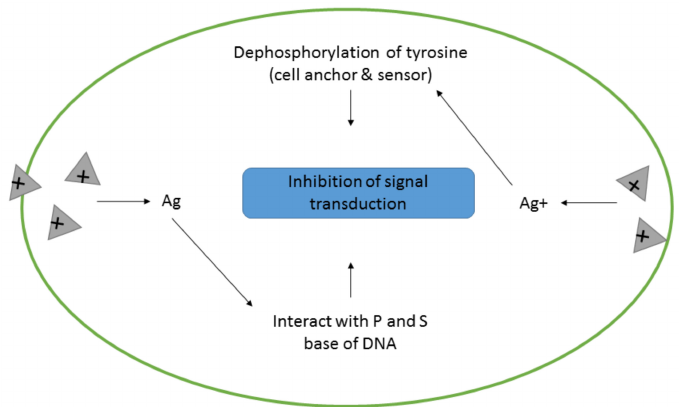
Figure 6. The mechanism of action of AgNPs effected through the inhibition of signal transduc- tion [117].